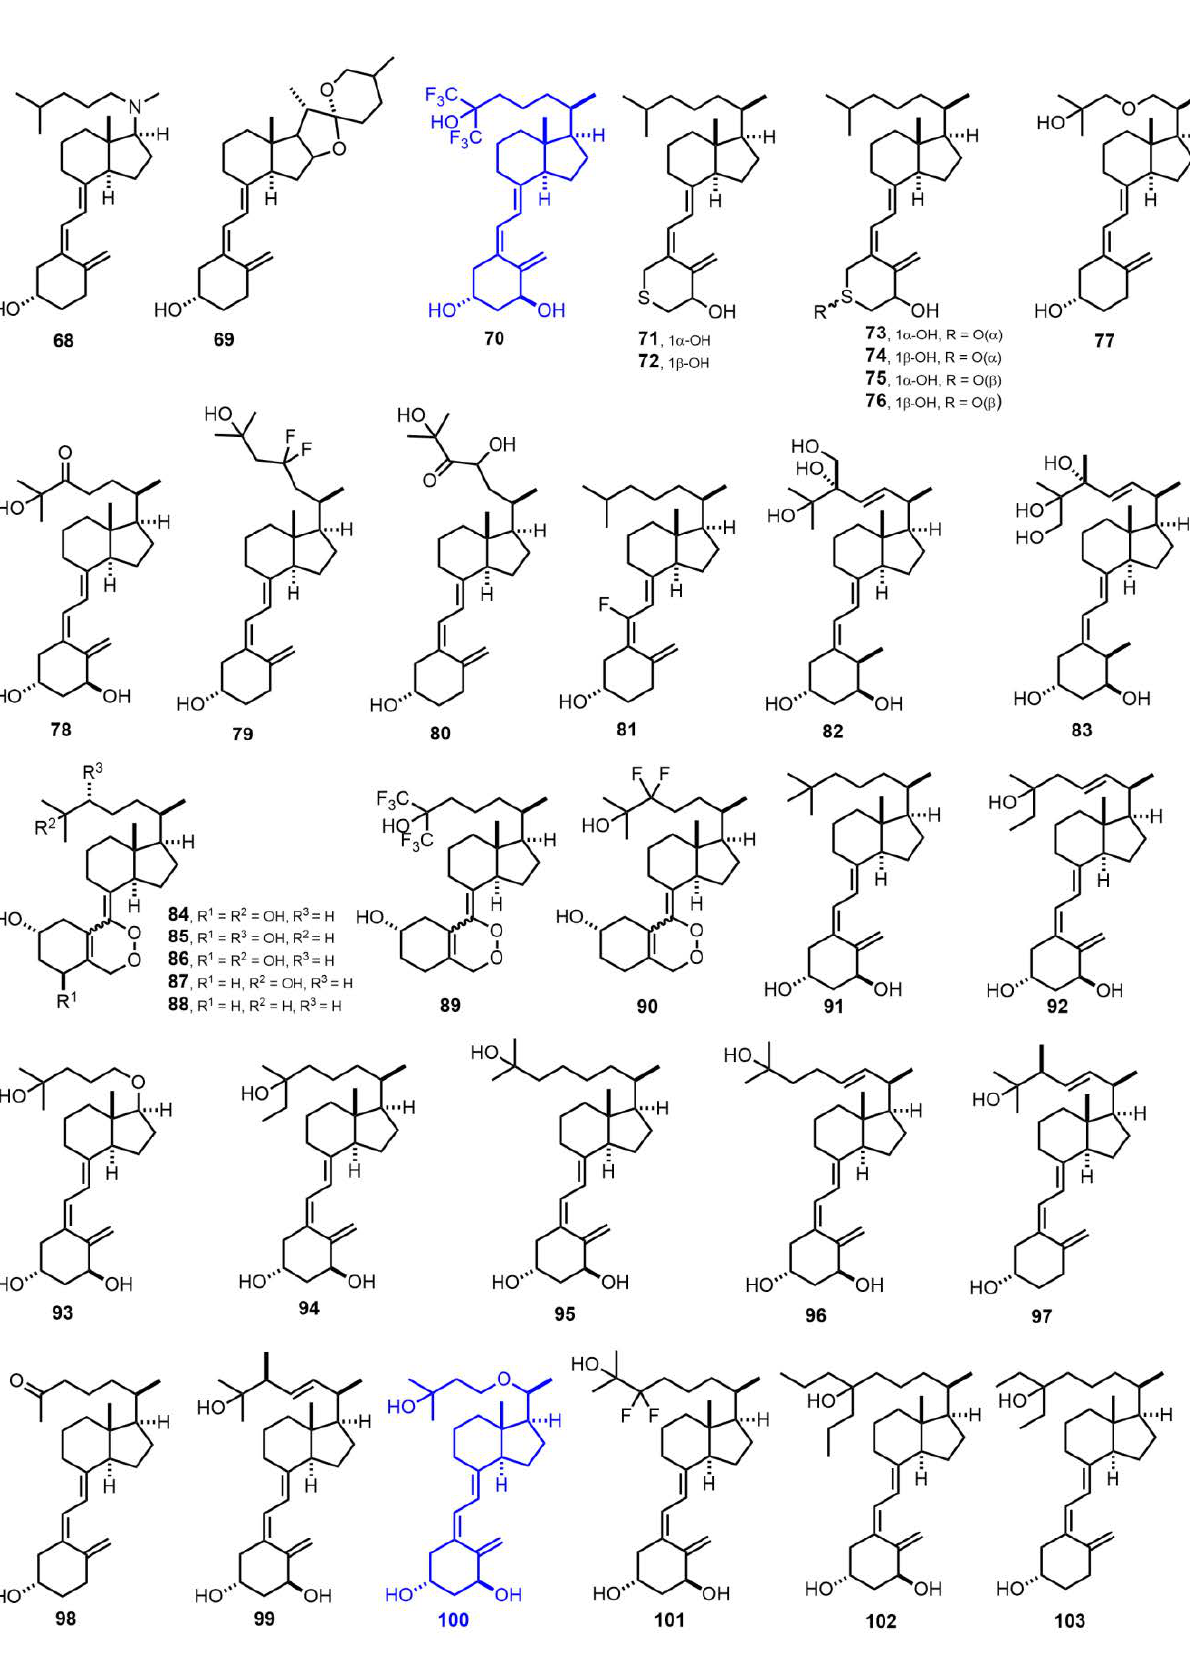
Figure 3. (1982-1987) [53 – 78].